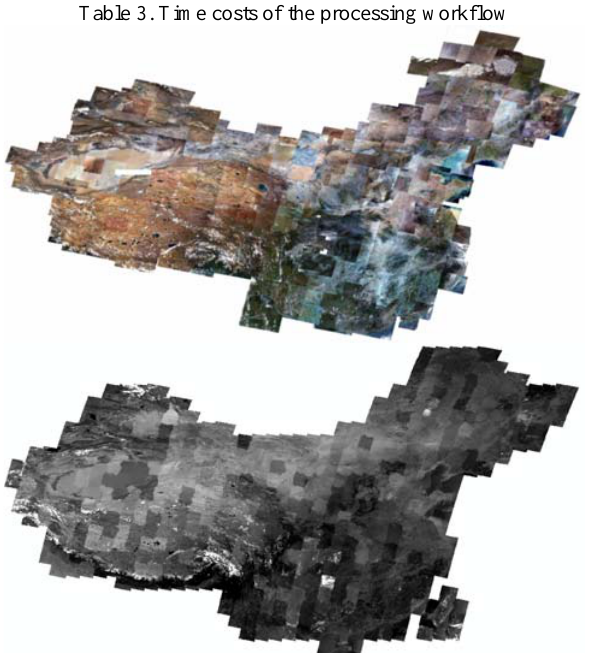
Figure 10. The ortho-rectified GF-1 WFV images (above) and the referencing Landsat-8 images